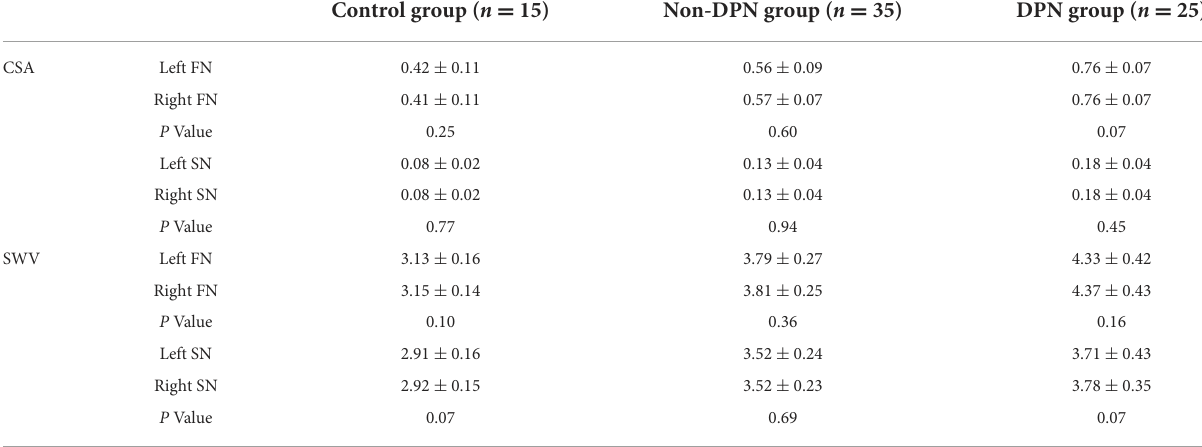
TABLE 3 Comparison of CSA and SWV of the left and right FN and SN among three groups. Control group ( n = 15)